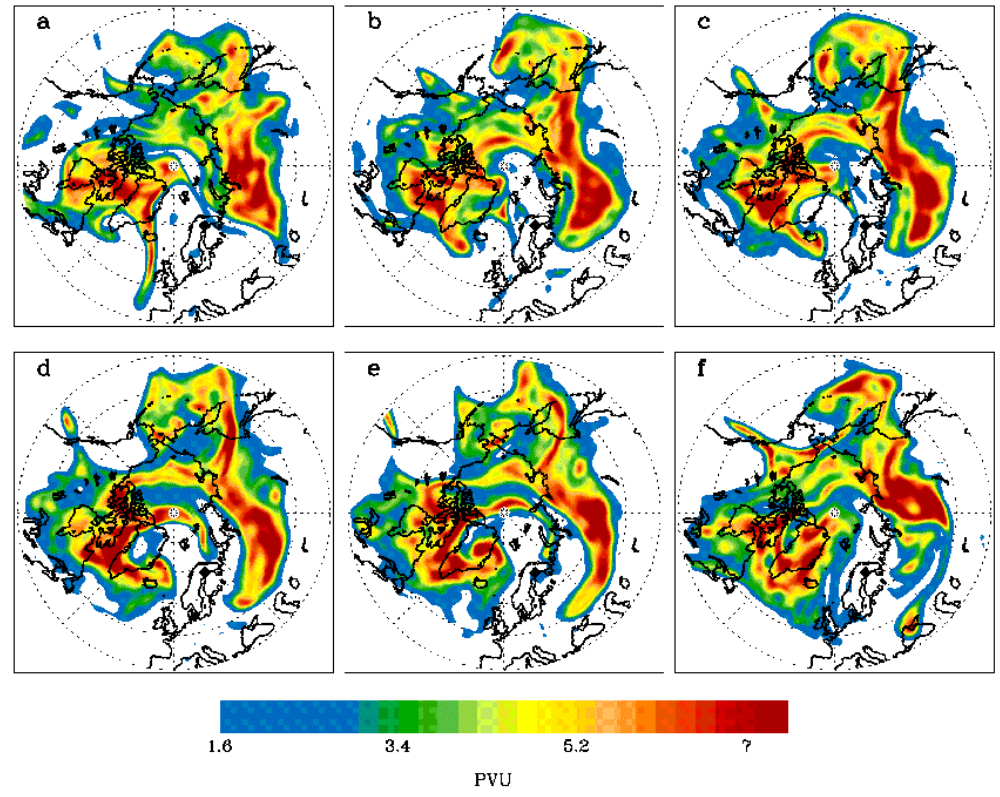
Fig. 2. PV charts calculated for the 310K isentropic surface at (a) 12:00UTC on 7 November; (b) 00:00UTC (c) 12:00UTC on 9 November (d) 00:00UTC (e) 12:00UTC on 10 November; (f) 12:00UTC on 11 November. Sodankyl¨a is marked with a diamond. Only PV > 1.6PVU is